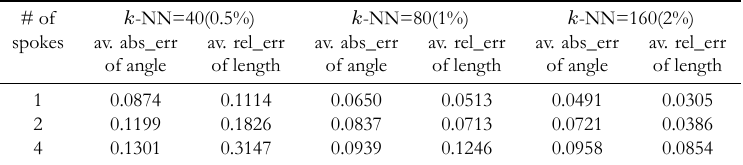
Table 3: Results of ℓ 1 MCDA on Gaussian-based radial data sets (with 10% outliers)